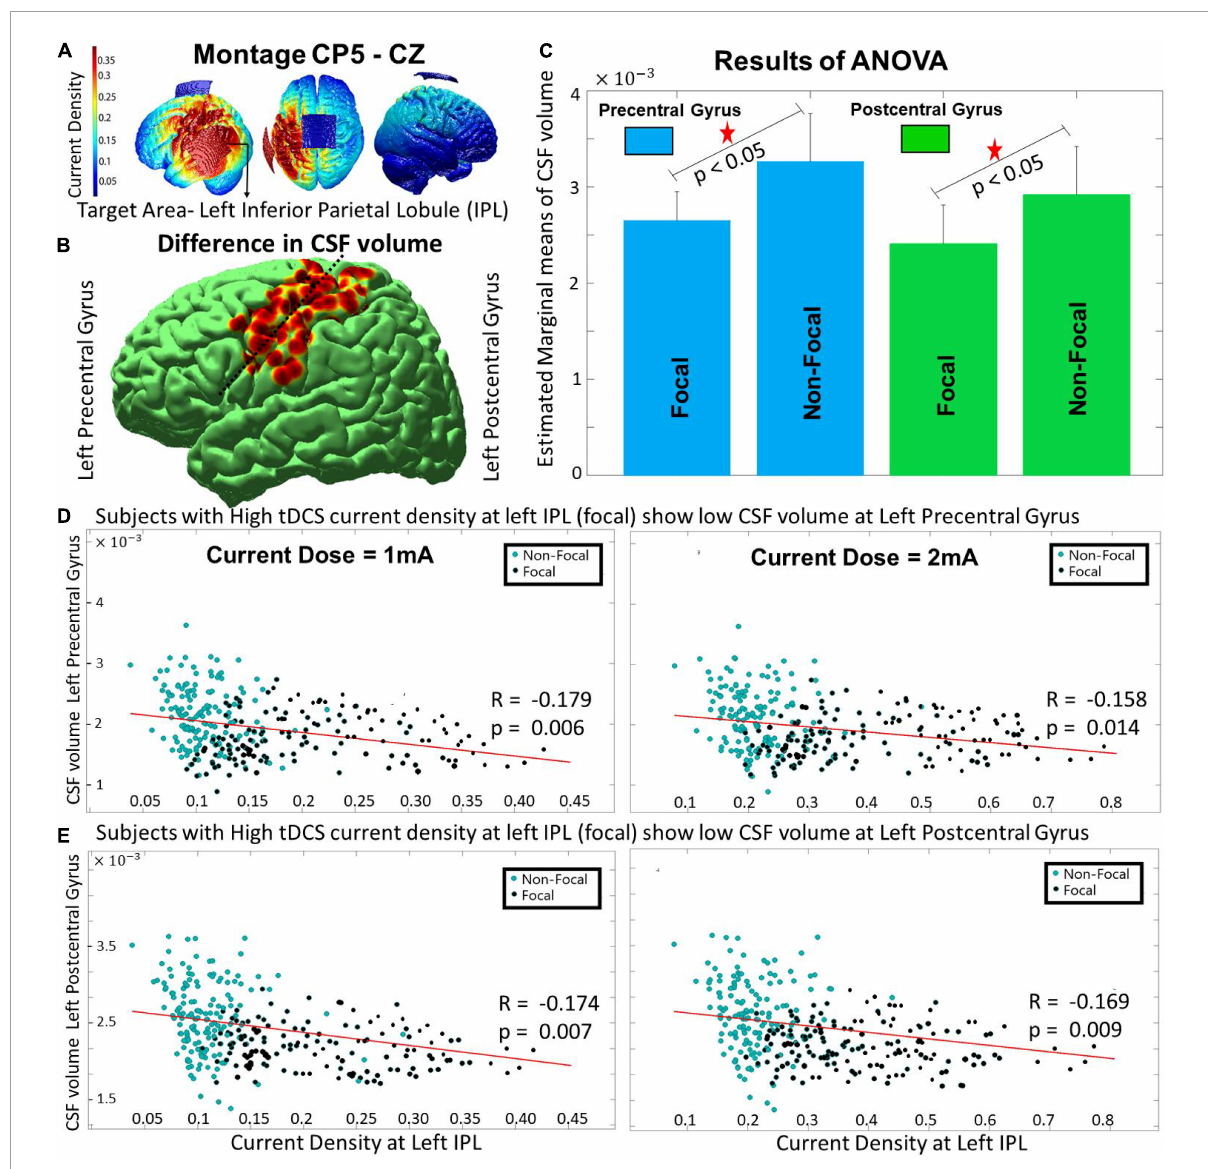
FIGURE2 The differences between the focal and non-focal group for the montage CP5-Cz with- (A) showing the spread of current density on an individual’s brain with target ROI at left IPL, (B) reflecting the location of focal ROIs- left pre- and post-central gyrus (nearby locations separated by dashed line) wherein significant ( p < 0.05) differences in CSF volume were observed, (C) highlighting that the focal group had lower CSF volume at the focal ROIs, (D,E) indicating that the decrease in CSF volume at focal ROIs (pre- and post-central gyrus) is linked with an